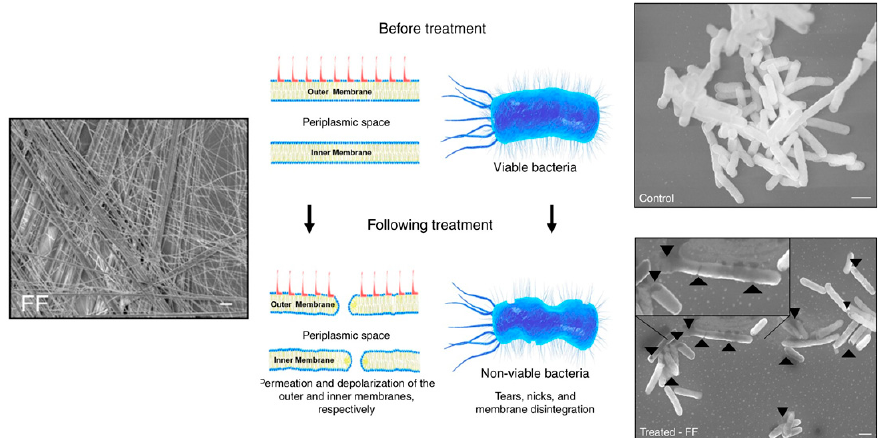
Figure 7. Diphenylalanine self-assembly and antimicrobial activity. (Left) SEM image of self-assembled nanofibers. Scale bar = 10 µ m. (Center) Schematic of proposed antimicrobial mechanism via membrane disruption and permeation. (Right) SEM of E. coli treated with GG (control) or FF nanotubes. Arrows mark altered membrane morphology caused by nanotube interactions. Scale bar = 1 µ m. Image adapted from [71] under the Creative Commons Attribution 4.0 International License